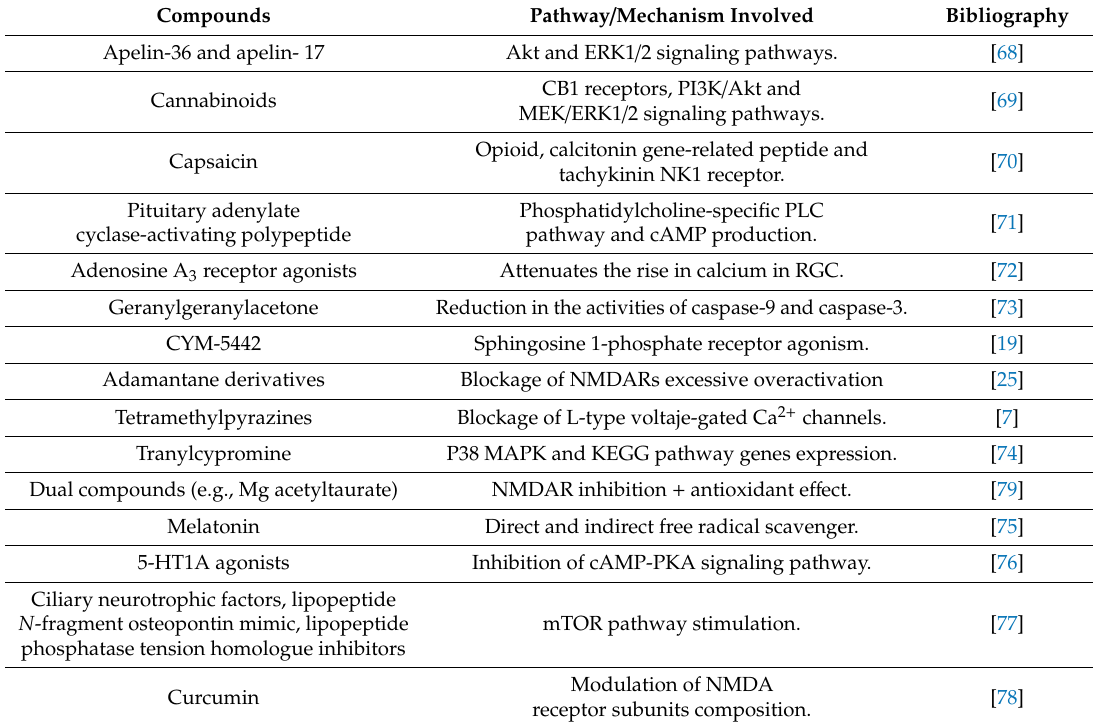
Table 1. Compounds evaluated in retina cells for their antiapoptotic activities. The pathway and / or mechanism involved / proposed is